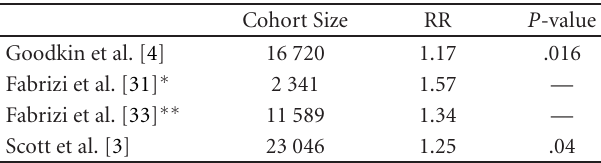
Table 1: Summary Estimates for Adjusted Relative Risk of Mortality among HCV+ve Dialysis